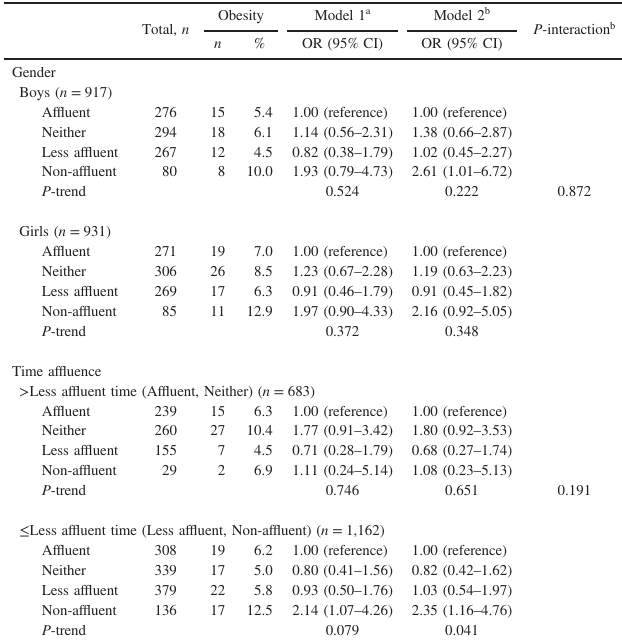
interaction was not statistically signi fi cant ( P -interaction = 0.191). Therefore, in the present study, the modi fi cation e ff ect of time a ffl uence on the association between economic status and obesity remained unclear.